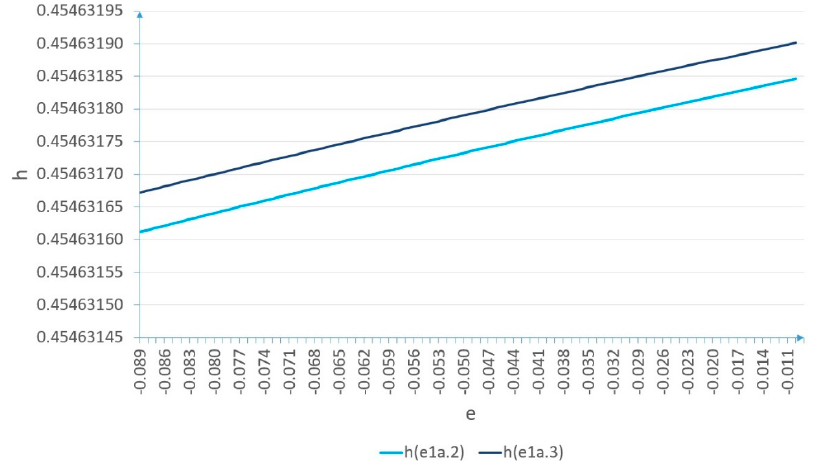
Figure 15. The result of the simulation of the h hypothesis value depending on the observation coefficients e1b.2 and e1b.3. Figures 13–15 show some of the most important functions representing the impact of the selected and most important observations on the final hypothesis h (the data were